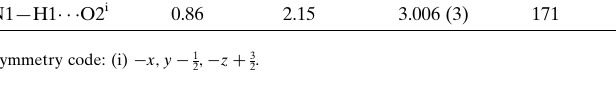
Table 2 Experimental